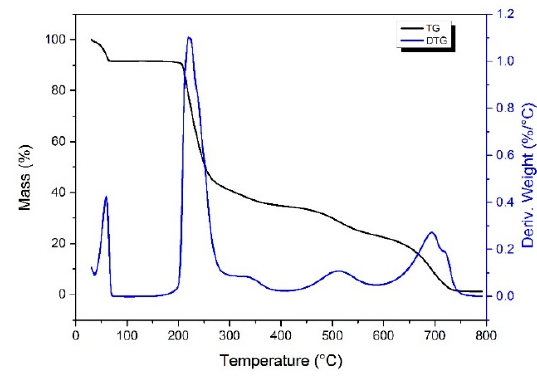
Figure 2. The TG-DTG curves of 5AT–1 at 10 °C min − 1 .